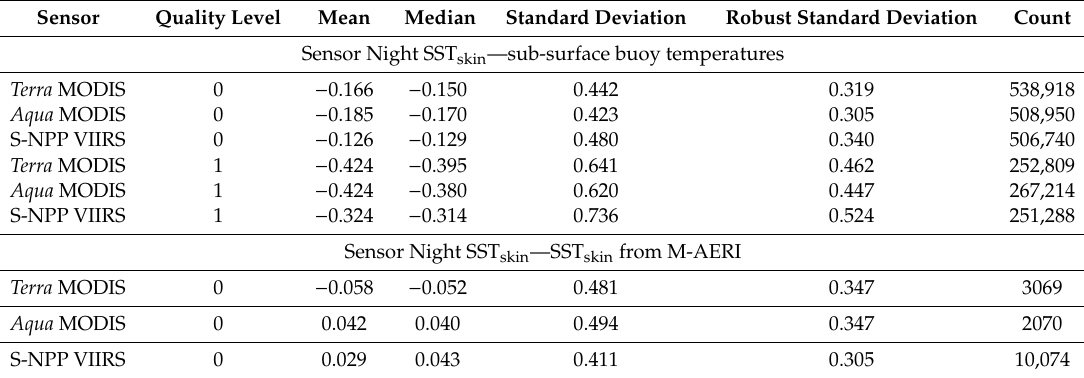
Table 5. Global statistics for MODIS and VIIRS night SST skin continuity products (Equation (4)) relative to both sub-surface buoy temperatures and SST skin derived from